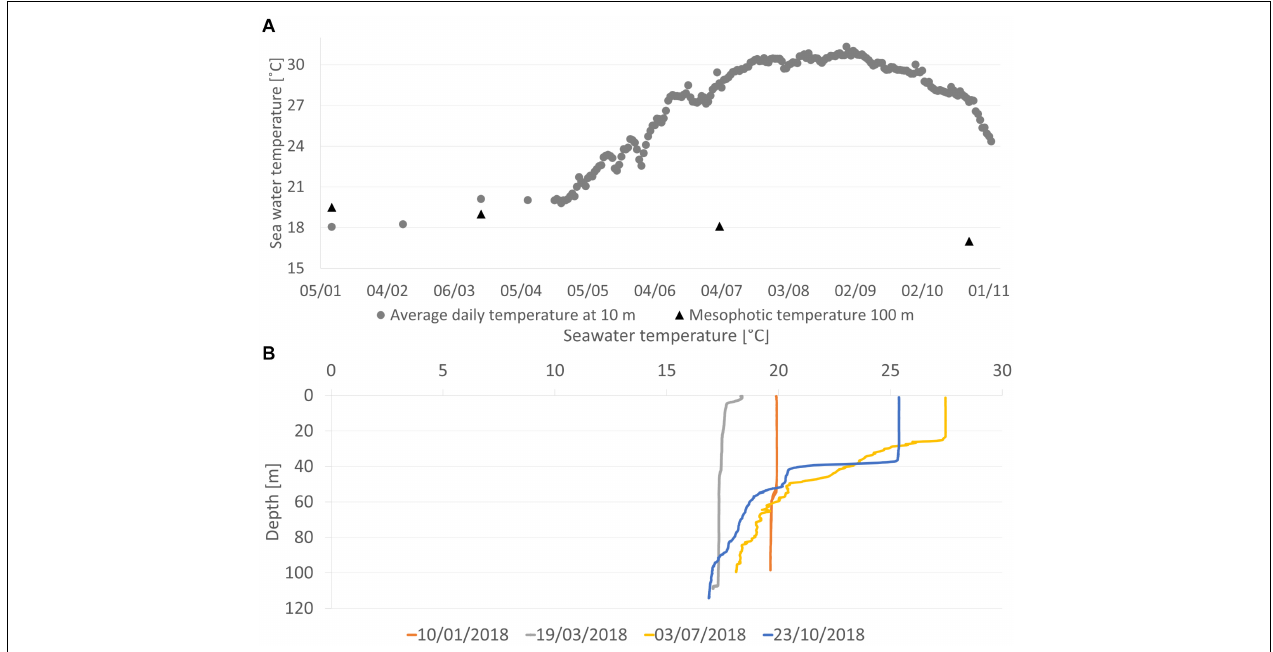
FIGURE 4 | Temperature regime measured from January to November 2018. (A) The temperature at the mesophotic sponge ground (100 m depth; black triangles) and at the shallow transplantation site (10 m depth; gray circles). The temperature was measured with CTD in both habitats. In addition, from April to November, the temperature in the shallow water was measured four times a day with a HOBO logger. (B) Temperature profile at the mesophotic sponge ground showing seasonal thermocline (measured with